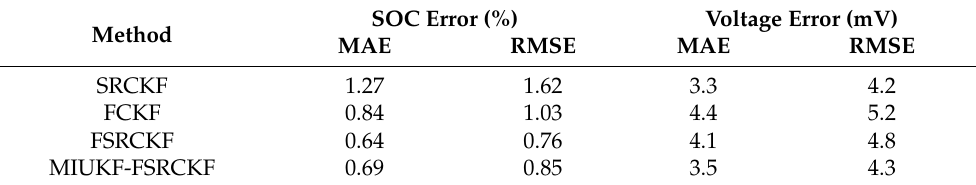
Figure 6. Comparison of the results of the four algorithms under the FUDS test: ( a ) SOC estimation result; ( b ) SOC error; ( c ) voltage estimation result; ( d ) voltage error. Table 4. SOC error and voltage error of each algorithm under